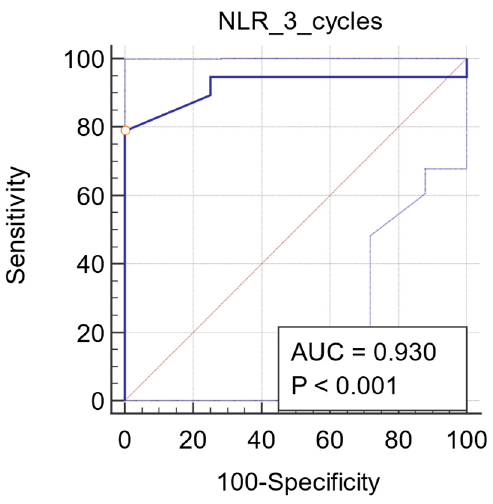
Figure 2. Regression analysis between NLR after three NACT cycles and PFS.